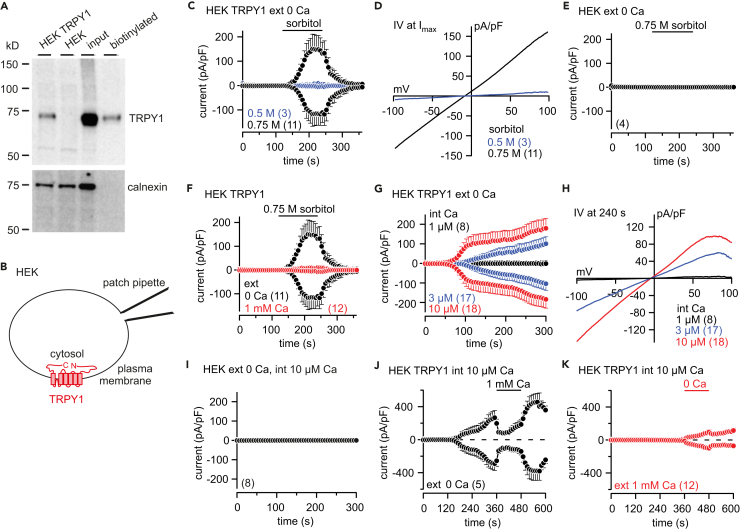
Ca2+-Dependent Regulation of TRPY1 Currents in Transfected HEK-293 Cells(A) Western blot of protein lysates from YVC1 cDNA-transfected (HEK TRPY1) and non-transfected (HEK) HEK-293 cells. Biotinylation of surface proteins shows that a considerable fraction of TRPY1 present in transfected HEK-293 cells (input) resides in the plasma membrane (biotinylated). The filter was stripped and incubated in the presence of an antibody directed against the intracellular protein calnexin as control.(B) Orientation of TRPY1 (red) in the plasma membrane with N- and C-termini residing within the cytosol.(C–K) Inward and outward currents at −80 and 80 mV, extracted from 400-ms ramps (0.5 Hz) spanning from −100 to 100 mV, Vh = 0 mV, plotted versus time (C, E–G, and I–K) and corresponding IVs (D and H) of maximum currents (Imax) from (C) or at 240 s from (G), activated by 0.5 or 0.75 M sorbitol (hyperosmotic shock; C–F) or indicated [Ca2+]cyt (int Ca; buffered with BAPTA; G-K) at 0 or 1 mM external (ext) Ca2+ in HEK TRPY1 cells (HEK TRPY1; C, D, F–H, J, and K) or non-transfected HEK-293 cells (HEK; E and I). The bars indicate application of 0.5 or 0.75 M sorbitol in C, E, and F, or 0 and 1 mM Ca2+-containing bath solution in K and J, respectively. The black traces in C and F are the same. Currents and IVs are normalized to the cell size (pA/pF) and are shown as means ± SEM (C, E–G, and I–K) and means (D and H) with the number of measured cells in brackets.